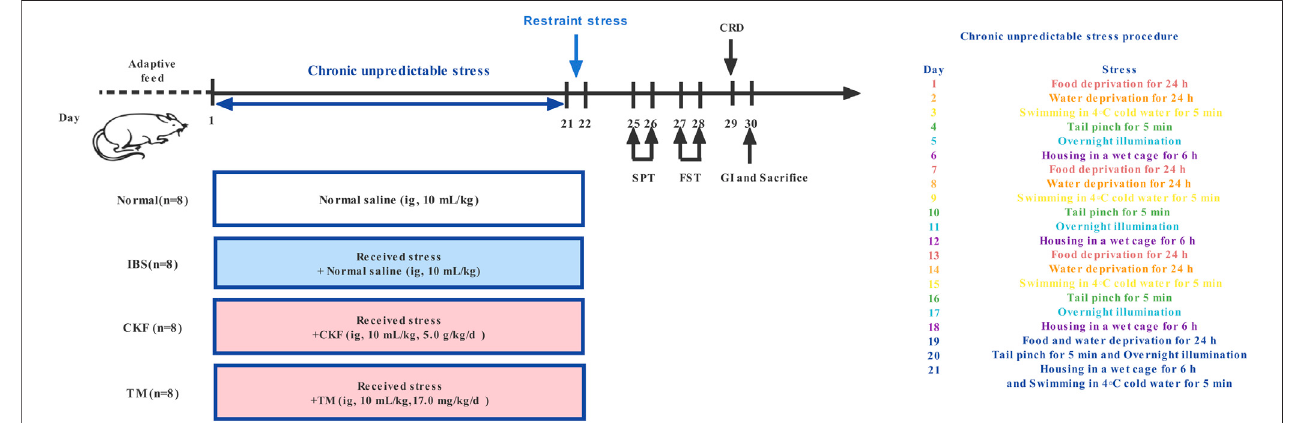
FIGURE 1 | Timeline of experimental